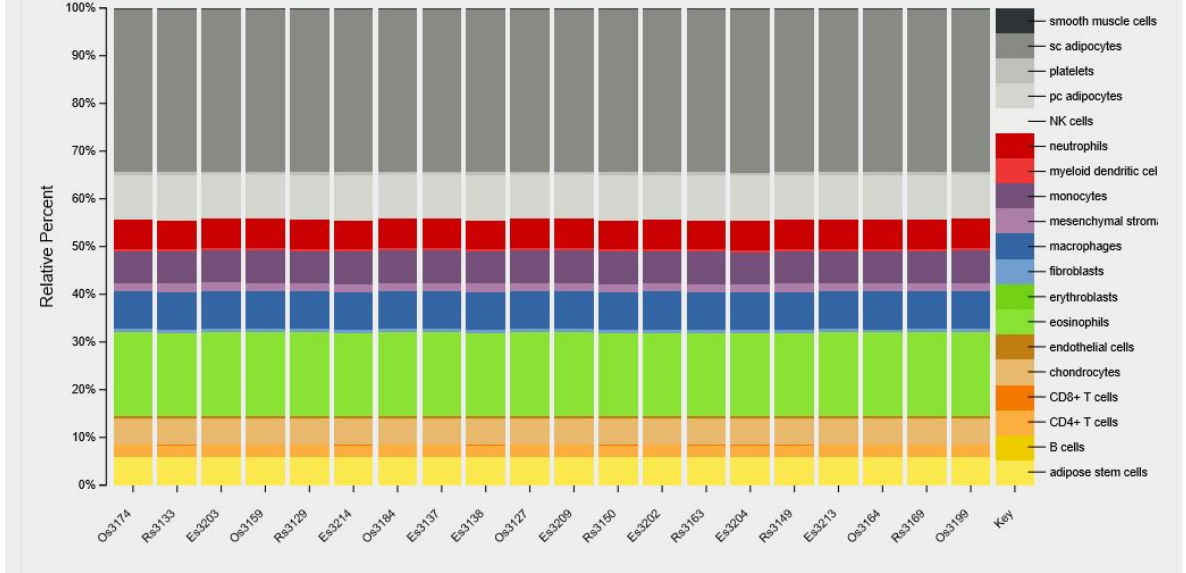
Figure 2. Cell-type heterogeneity in the different adipose tissue samples. CIBERSORT was used for the measurement of cell-type proportions from adipose-tissue microarray samples. Sample numbers starting with O, E, and R are from HFoleic, HFepa, and Reference groups, respectively. HFoleic, mice from oleic/control lineage fed with the obesogenic diet; HFepa, mice from EPA/omega 3 lineage fed with the obesogenic diet; Reference, mice from oleic/control lineage fed with the normocaloric diet.